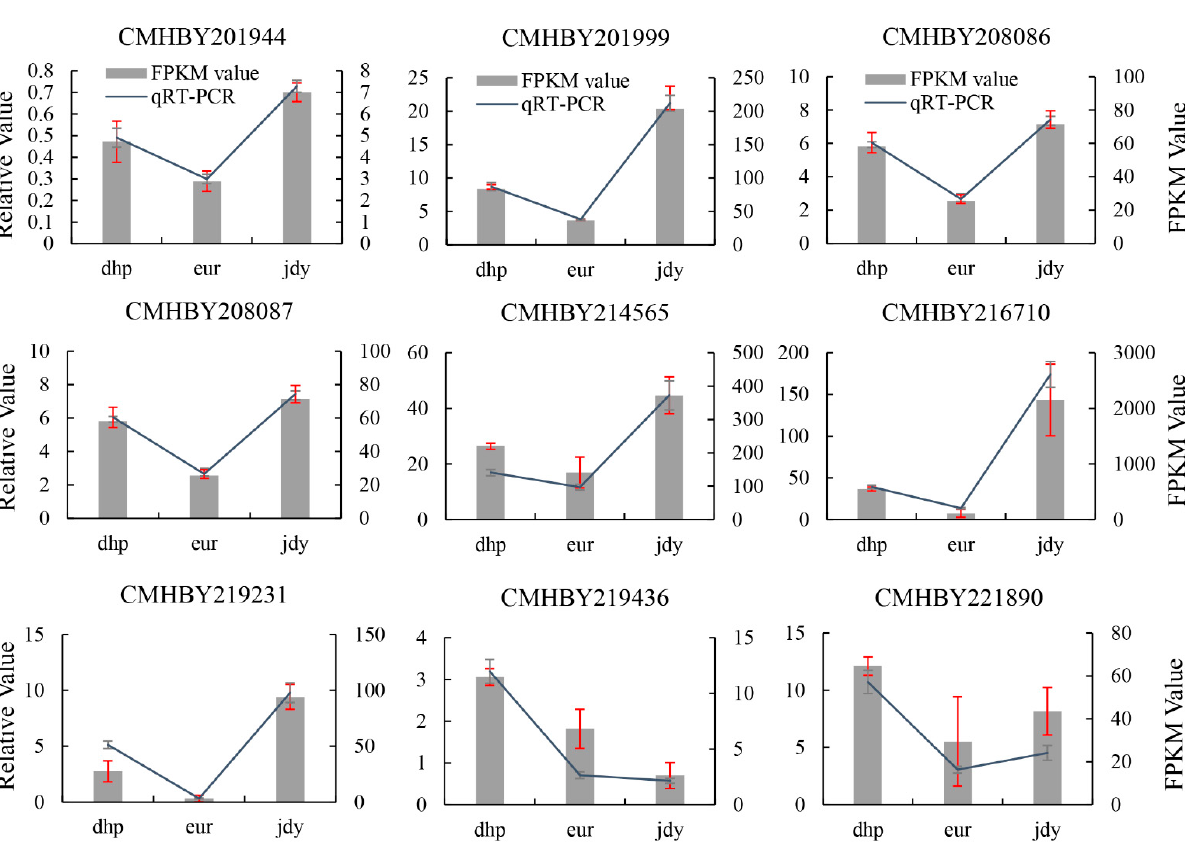
Figure 9. Validation of DEGs by qRT-PCR in the kernels of three chestnut cultivars versus by RNA-Seq. dark blue line: qRT-PCR expression, gray bars: transcriptomics RNA-Seq analysis (FPKM).